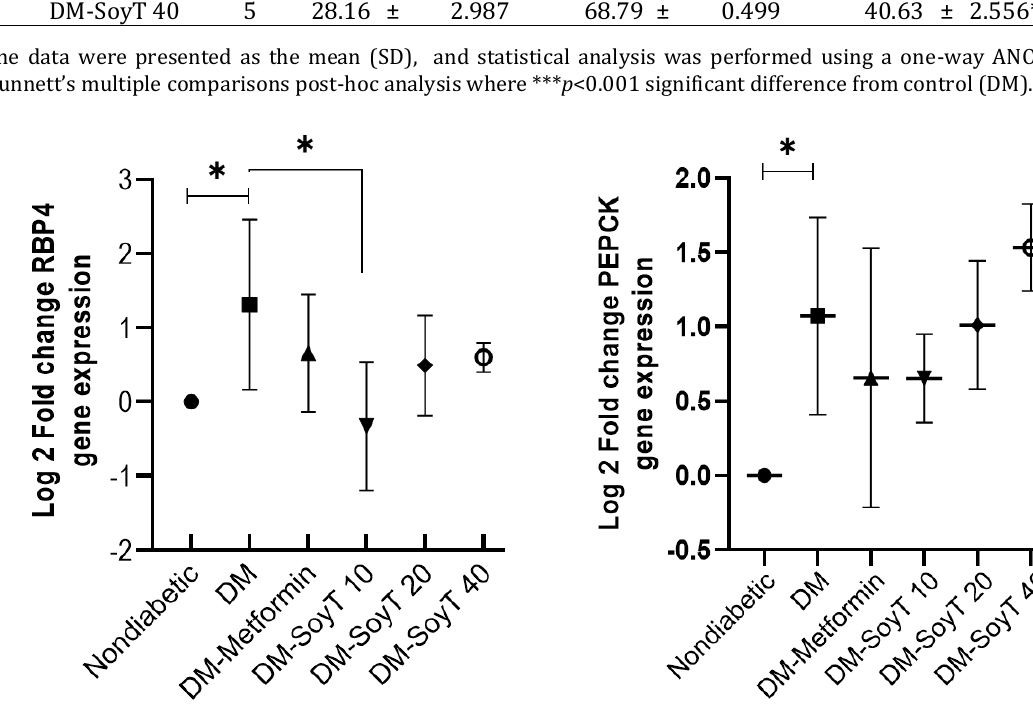
Table VII. HDL levels after 3 weeks of treatment Group n Treatment Baseline End Change from baseline